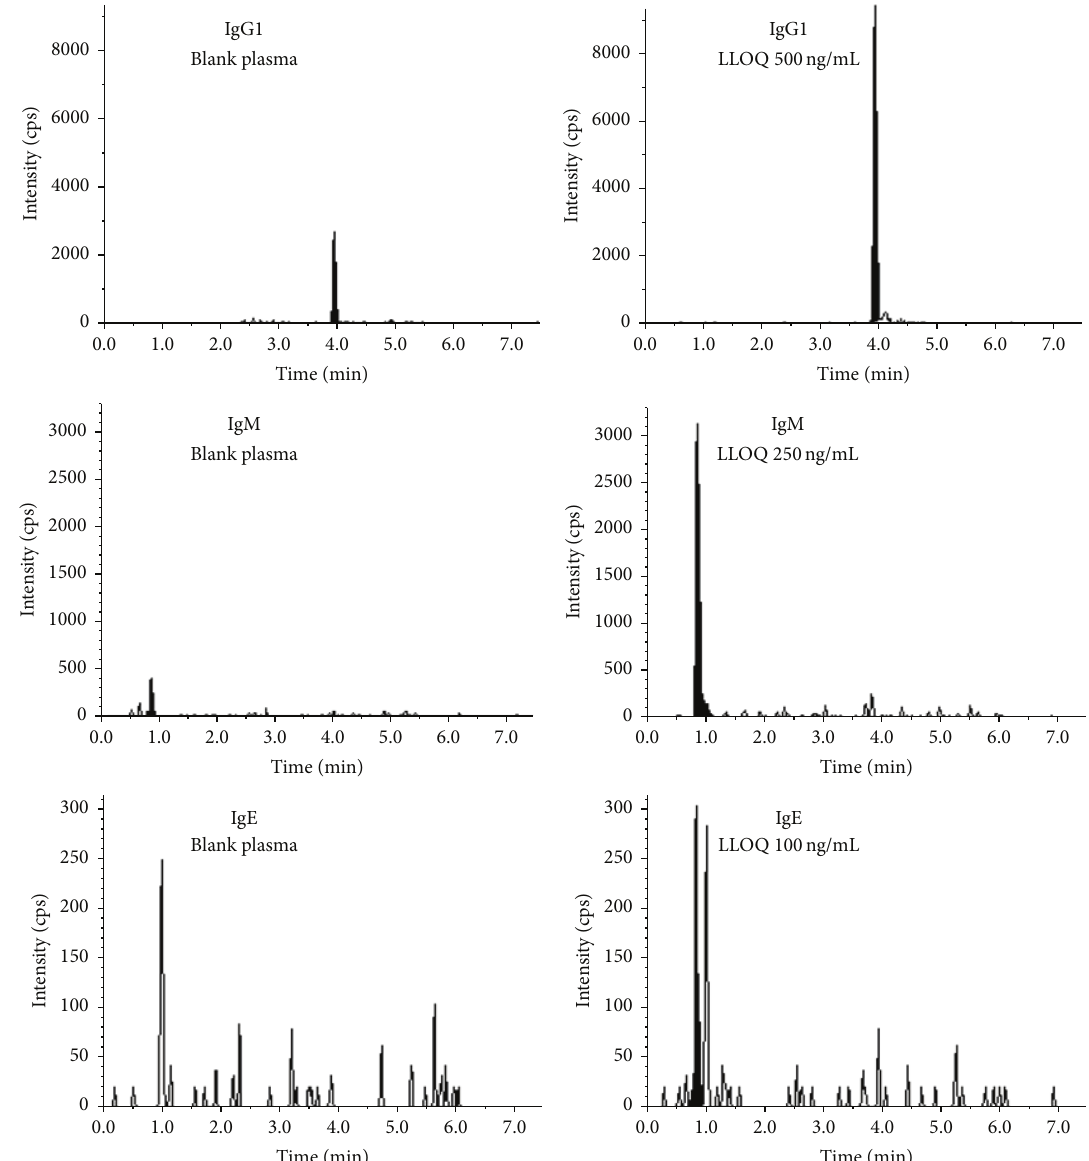
Figure 2: LC/MS chromatograms of unique peptides of IgG1 (top), IgM (middle), and IgE (bottom) from blank human plasma (left) and LLOQ samples (right) after immunocapture when using drug as ADA capture reagent.